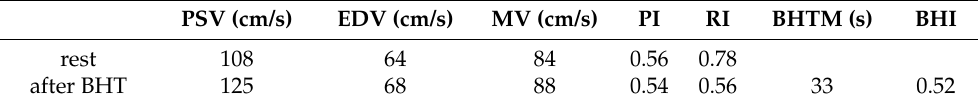
Table 2. Transcranial Color Doppler (TCCD) and breath holding test (BHT)